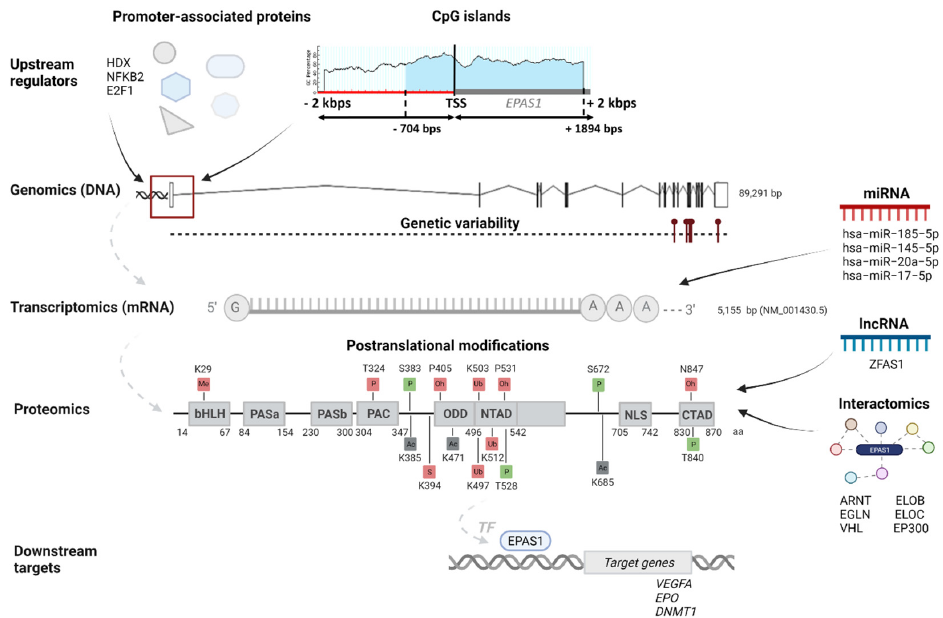
Figure 1. An integrated EPAS1 multi-omics map. An integrative map visualizes important genomics, transcriptomics, proteomics, interactomics data, together with the upstream regulators and downstream targets of the EPAS1 gene. CpG island is indicated with blue. Post-translational modifications are indicated in squares, with green squares indicating an effect on enhanced EPAS1 stability and activity, red squares indicating an effect on decreased EPAS1 stability and activity, and gray squares indicating ambiguous effect. Me indicates methylation, P indicates phosphorylation, Ac indicates acetylation, S indicates SUMOylation, Ub indicates ubiquitination, and Oh indicates